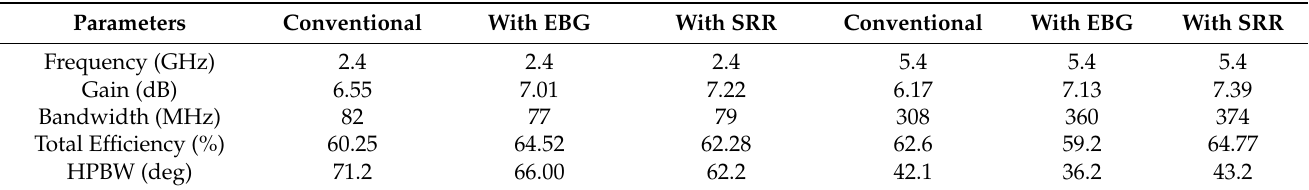
Table 5. Comparative results of (conventional vs. EBG-based vs. SRR-based) antennas in normal scenario.